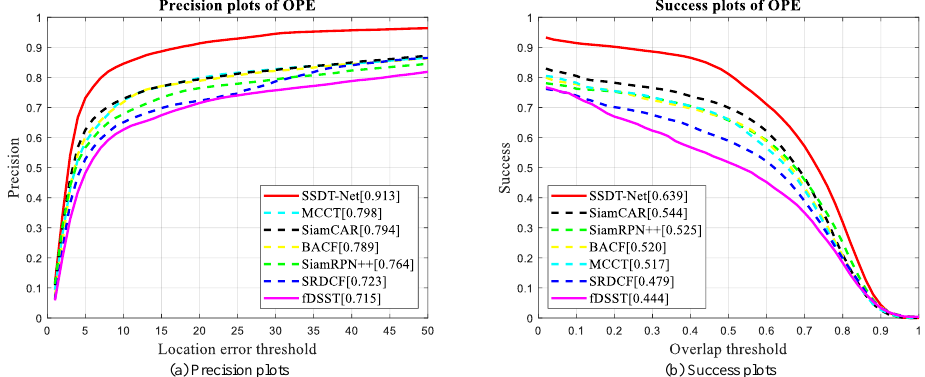
Figure 7. Comparisons with color video trackers on corresponding false-color videos. Our approach fulfills the best accuracy with an AUC of 63.9%.